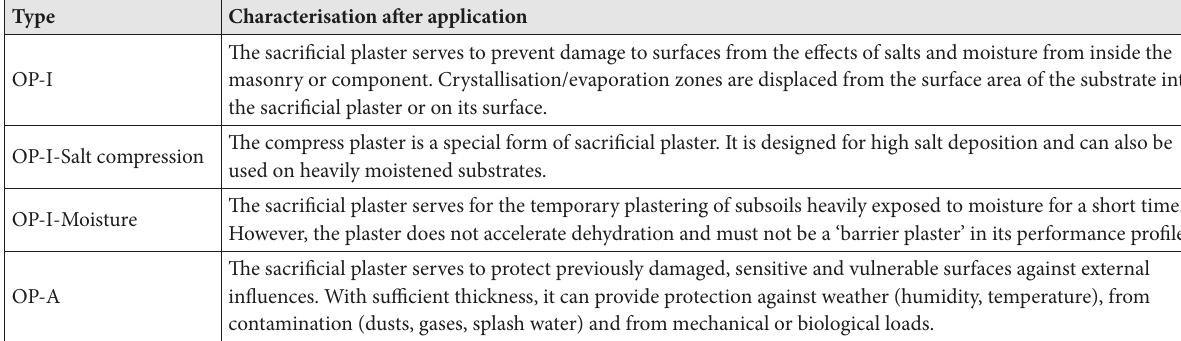
Table 1 The definition of sacrificial plaster in Merkblatt 2-10-06/D, Opferputze.